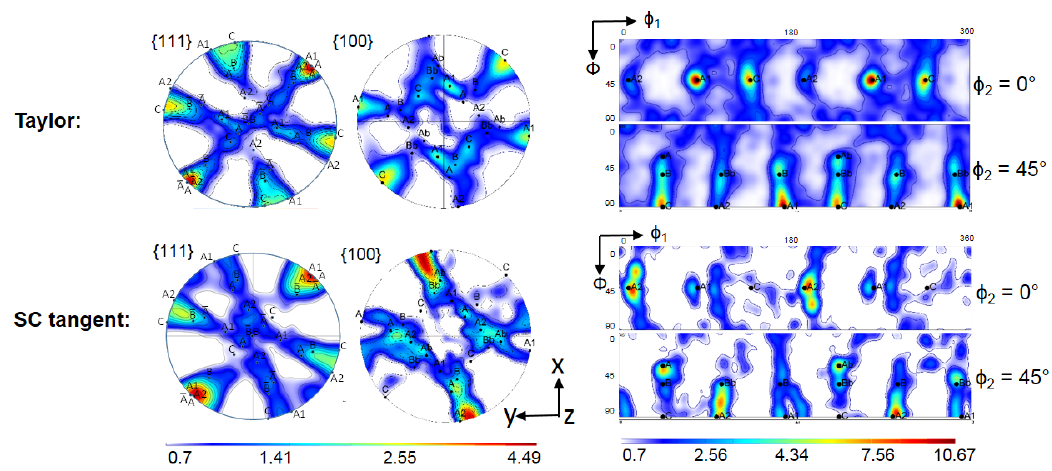
Figure 6. Simulated textures after one ‐ pass ECAP obtained by the Taylor and the self ‐ consistent (SC) (tangent) model in {111} and {100} pole figures, as well as in the φ 2 = 0° and 45° ODF sections.